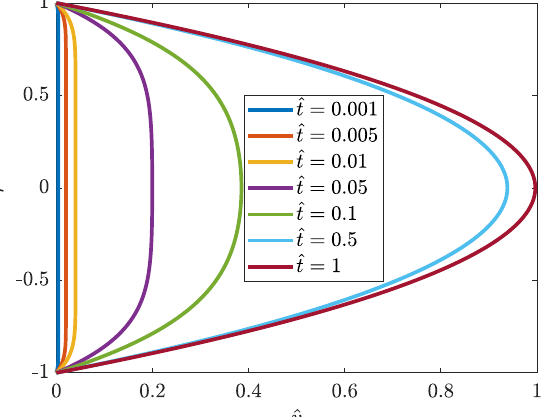
Figure 3. Development of velocity profile in RGS-accelerated flow driven by a step change of pressure gradient.